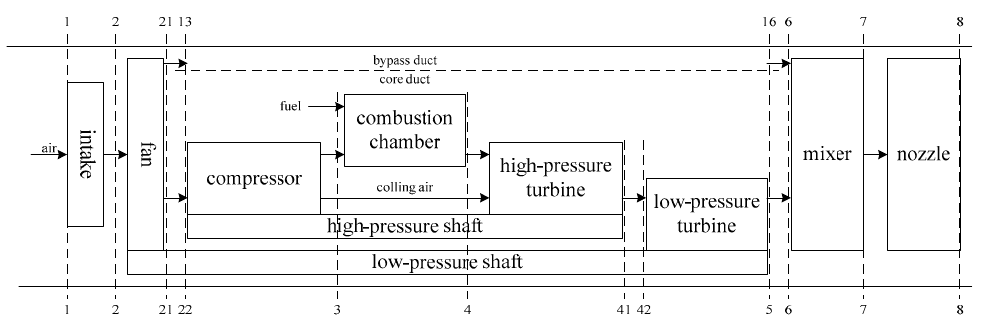
Figure 1. Schematic diagram of a turbofan engine.